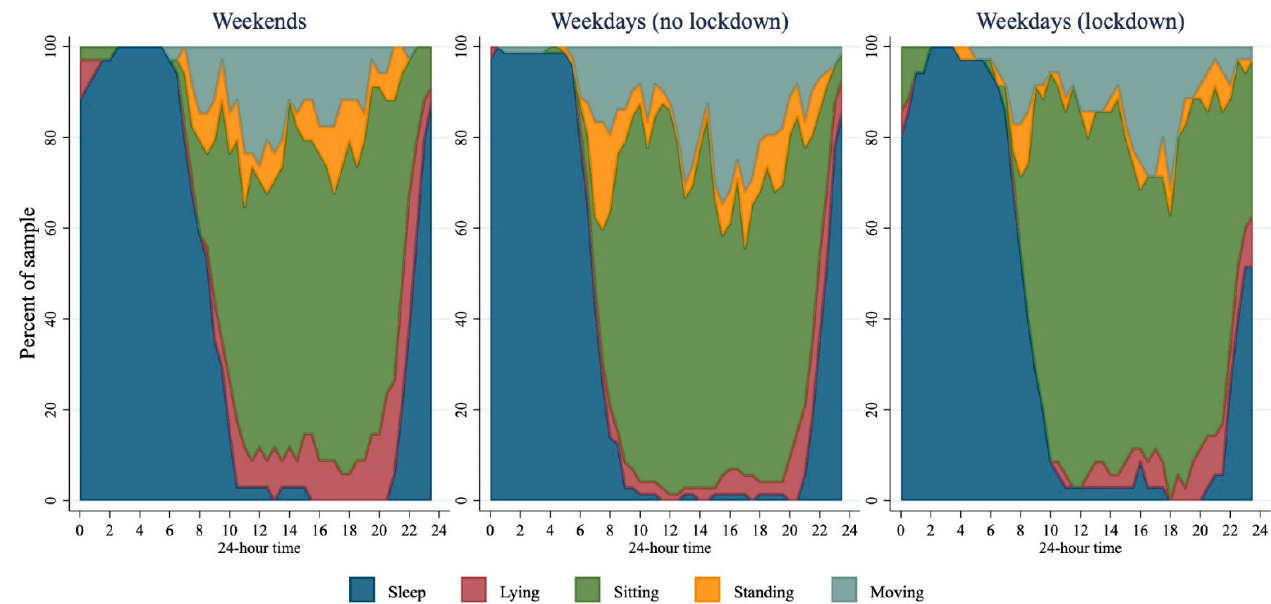
Figure 5. Posture across 24 h for weekends ( n = 34), weekdays before lockdown ( n = 72), and weekdays during lockdown ( n = 35).